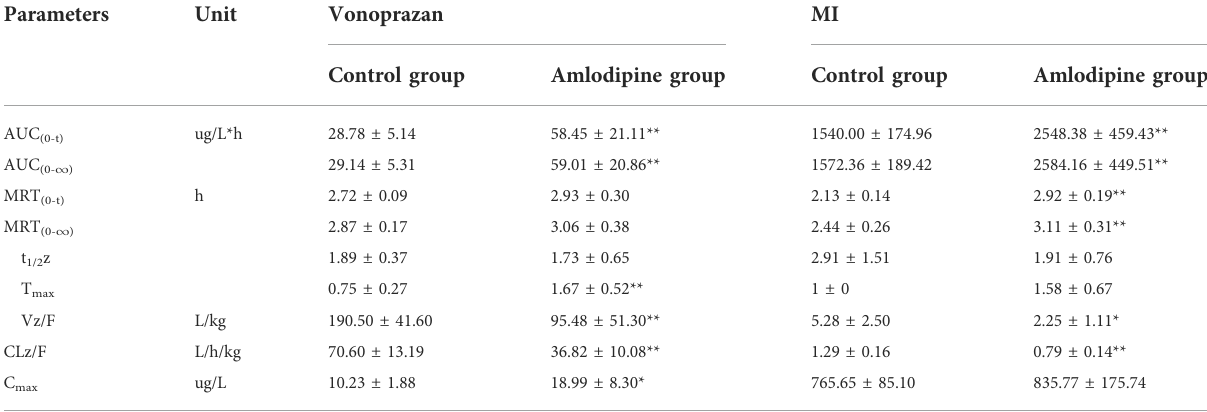
* p < 0.05 indicates the statistical difference between the two groups. ** p < 0.01 indicates the statistical difference between the two groups. AUC, the area under the concentration – time curve; MRT, the mean residence time; t1/2, half-life period; Tmax, maximum plasma time; Vz/E, apparent volume of distribution; CLz/F, clearance; Cmax, peak plasma concentration.